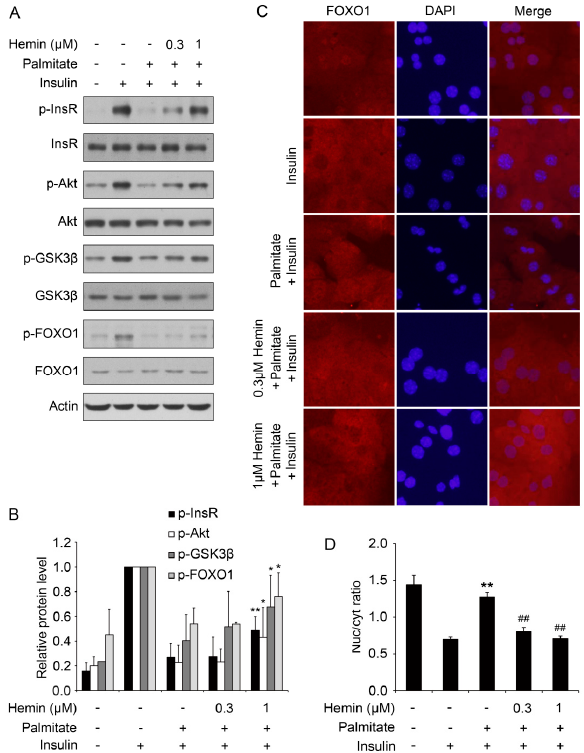
Figure 1. Hemin alleviates palmitate-induced insulin resistance in mouse primary hepatocytes. ( A ) Hemin improved insulin signaling, including the phosphorylation of InsR, Akt, Gsk3 β and FoxO1 in hepatocytes under insulin-resistant conditions. Mouse primary hepatocytes were treated with hemin at the indicated concentration for 6 h, and then palmitate was added at a final concentration of 0.6 mM to induce insulin resistance for 18 h. Subsequently, the cells were stimulated with or without 100 nM insulin for 15 min and harvested for western blot; ( B ) Quantification of the protein level in ( A ). * p < 0.05; ** p < 0.01 versus hepatocytes stimulated by insulin with palmitate pretreatment and without hemin treatment; ( C ) Hemin enhances insulin-induced cytoplasmic translocation of FoxO1 under insulin resistance condition induced by palmitate. After treatment with hemin at the indicated concentration for 6 h, mouse primary hepatocytes were treated with 0.3 mM palmitate for 18 h, and then stimulated with 100 nM insulin for 10 min for immunofluorescence. Nuclei were stained with DAPI; ( D ) Quantitative analysis of FoxO1 translocation in ( C ). ** p < 0.01 versus hepatocytes stimulated with insulin without treatment of palmitate and hemin; ## p < 0.01 versus hepatocytes stimulated by insulin with palmitate pretreatment and without hemin treatment. In this and all other figures, data are shown as mean ± standard deviation.